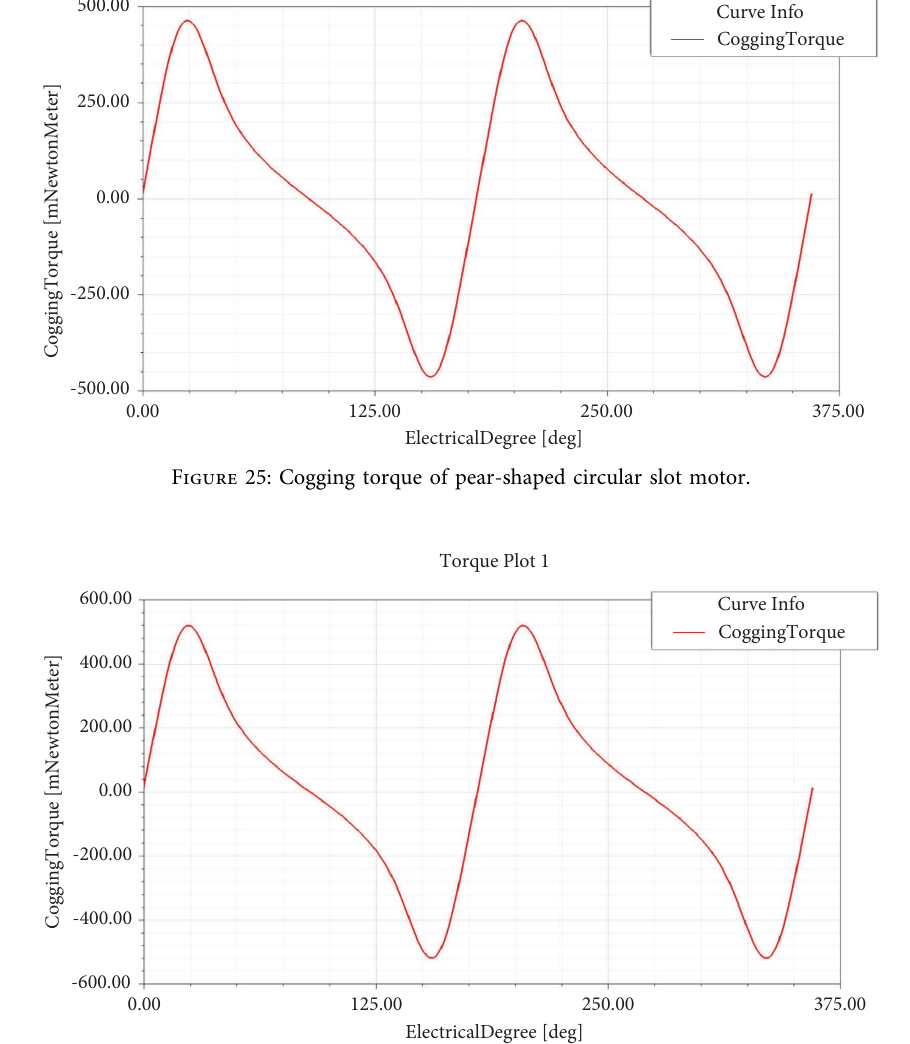
Figure 26: Cogging torque of fat-bottom ladder slot motor.